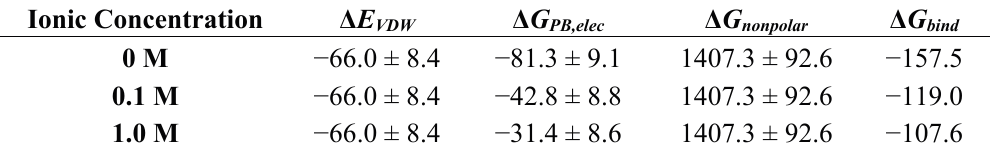
Table 4. Binding energies of the p5+14 peptide to the A β (17-42) fibril computed using the MM-PB/SA